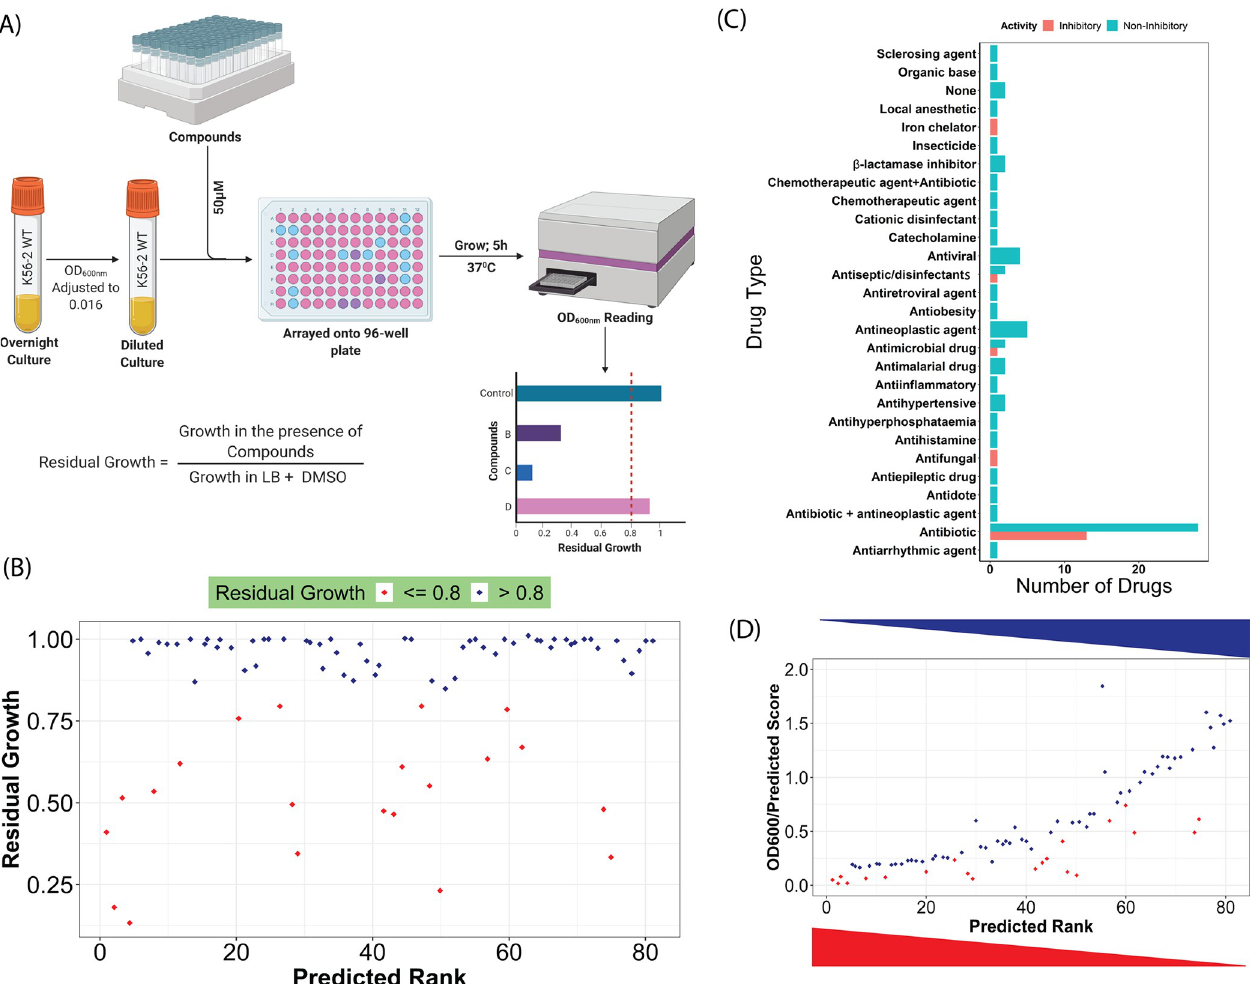
Fig 2. In vitro testing of top-ranked predicted compounds from an FDA-approved compound library. (A) Schematic of the screening protocol. Eighty-one commercially available compounds (from the top 100) were screened. (B) The screening identified 21 bioactive compounds with a positive predictive value (PPV) of 25.9%. Dark blue and red represent inactive and active compounds, respectively. (C) The top 100 ranked compounds selected for empirical testing belong to different drug families. Most of the compounds exhibiting bioactivity were known antibiotics or antimicrobial compounds. (D) The ratio of OD 600nm and prediction scores were plotted against the predicted rank of the corresponding compounds. The results show a linear correlation (Pearson correlation, R = 0.54) between the prediction score and bioactivity. The predicted score is the probability of a compound being active as calculated by the ML model. The predicted rank is the order of the compounds based on the predicted score, where compounds with the higher predicted scores are ranked higher. The red and blue triangles show the gradient of predicted rank and growth (measured as OD 600nm ), respectively. Dark blue and red indicate compounds’ probability of being inactive and active, respectively. Results are the average of at least three independent biological replicates. Fig 2A was created with https://biorender.com/